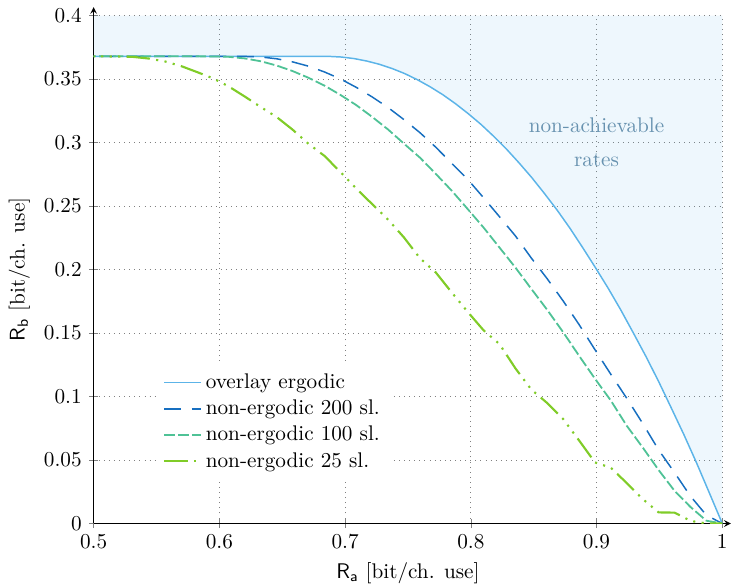
Figure 3. Asymptotic non-ergodic rate regions for overlay allocation. We fix ρ a / σ 2 = ρ b / σ 2 = 0 dB. The number of time slots are in the set M ∈ { 25,100,200 } and the target outage probability for service S a is P ∗ out = 10 − 3 . The asymptotic ergodic rate region for the overlay allocation is also provided for